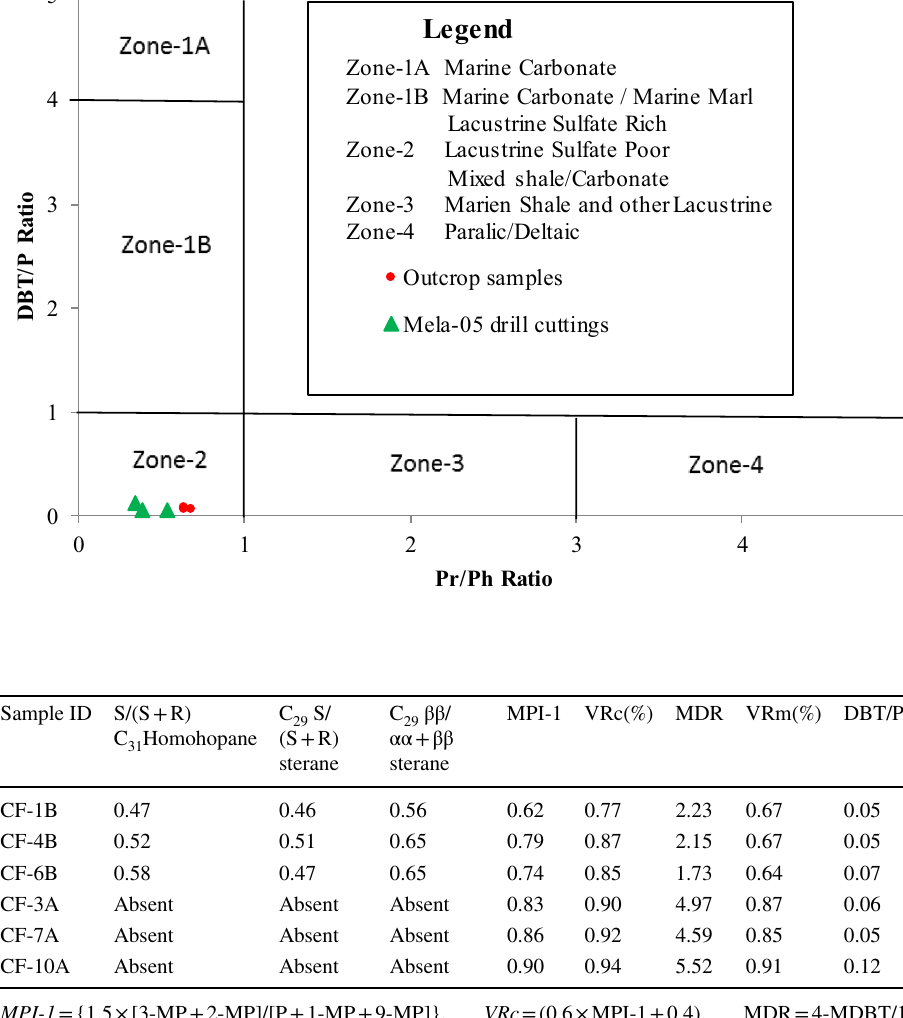
Fig. 13 The VRc% versus VRm% cross-plot, showing the maturity difference in the drill cuttings and outcrop samples of the Chichali Formation